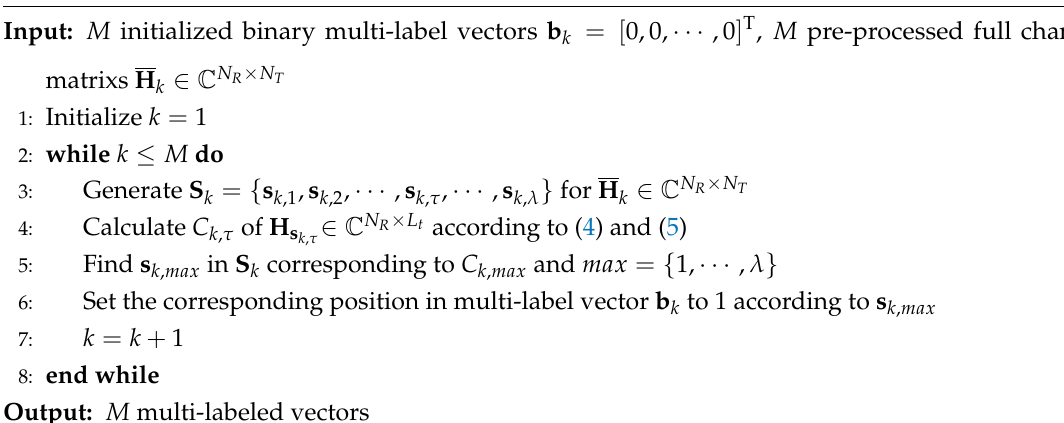
Algorithm 1 Multi-label generation